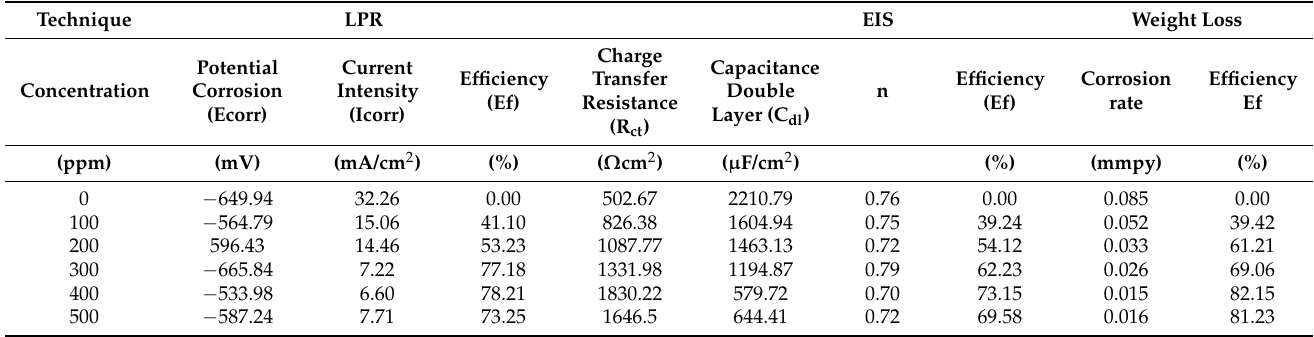
Table 3. Corrosion inhibition efficiency results of the Pex 50%–Gx 50%